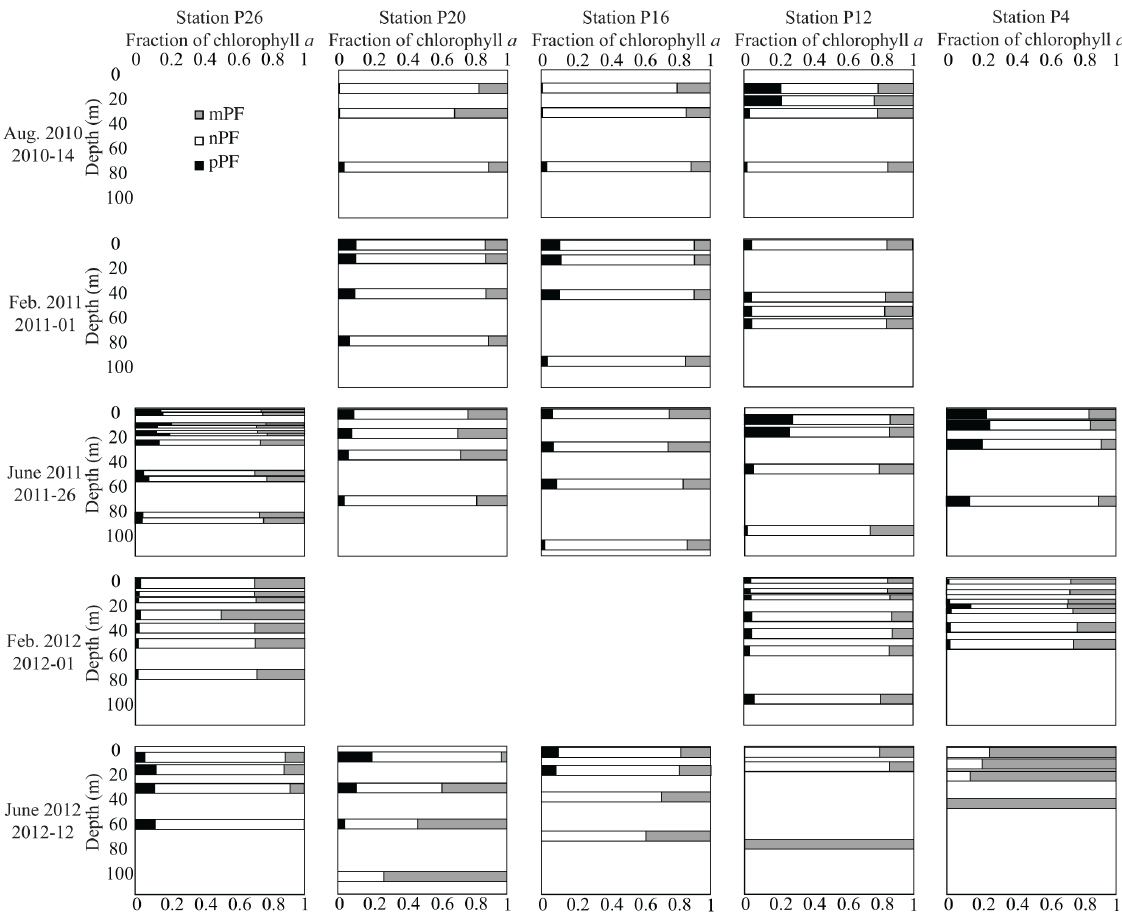
Figure 5. Pigment proportion factors (PFs) for each phytoplankton size class plotted as a function of sample depth at stations sampled on Line P during the five cruises in the study. All data were collected from Niskin